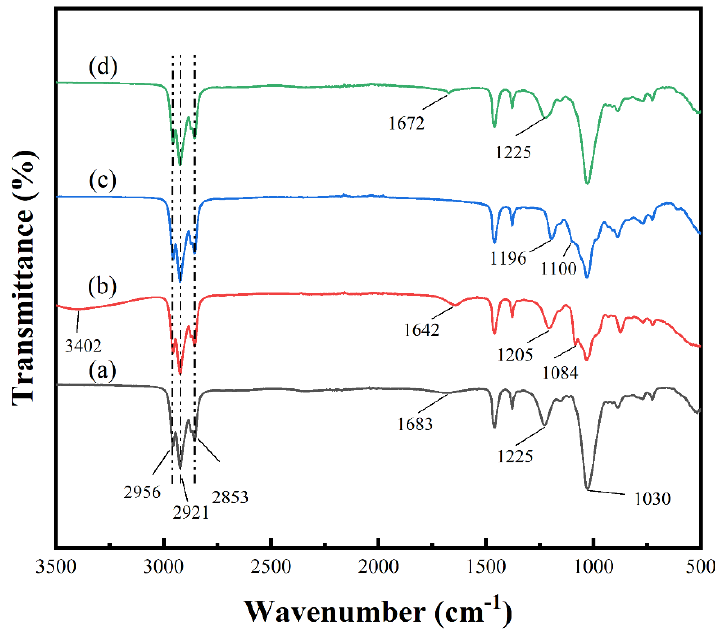
Figure 10. FT-IR spectra of ( a ) untreated D2EHPA, ( b ) saponified D2EHPA, ( c ) extracted D2EHPA, and ( d ) stripped D2EHPA. The extraction conditions: room temperature (298 K), [D2EHPA] = 1 mol/L, initial [Fe 3+ ] = 12.25 g/L, extraction time = 20 min, saponification rate = 70%, initial pH = 1.00, and phase ratio = 1:1. The stripping conditions: [oxalic acid] = 1 mol/L, stripping time = 40 min, stripping temperature = 313 K, and phase ratio =